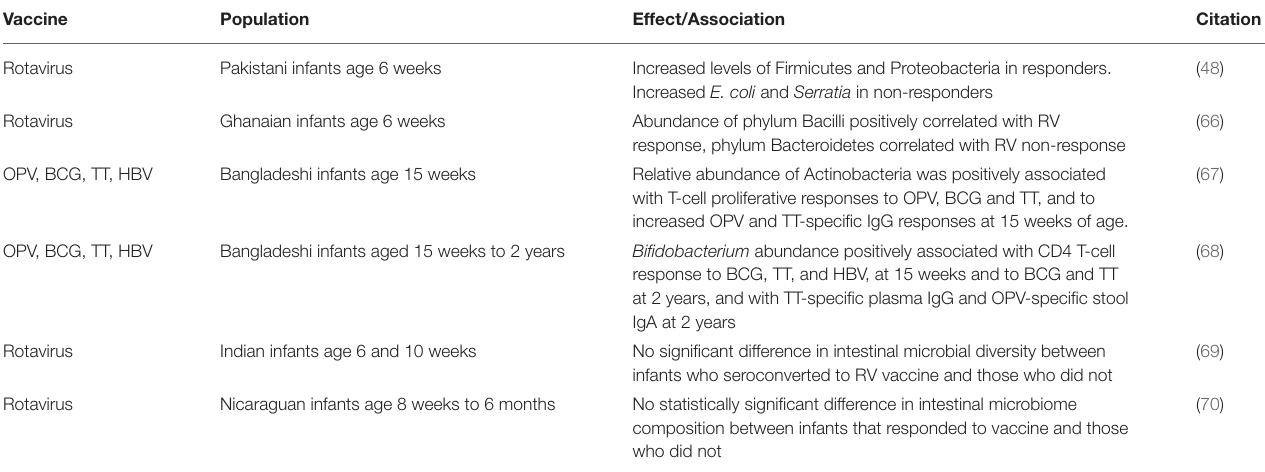
TABLE 1 | Association between microbiome and vaccine response in infants (up to age 2). Vaccine